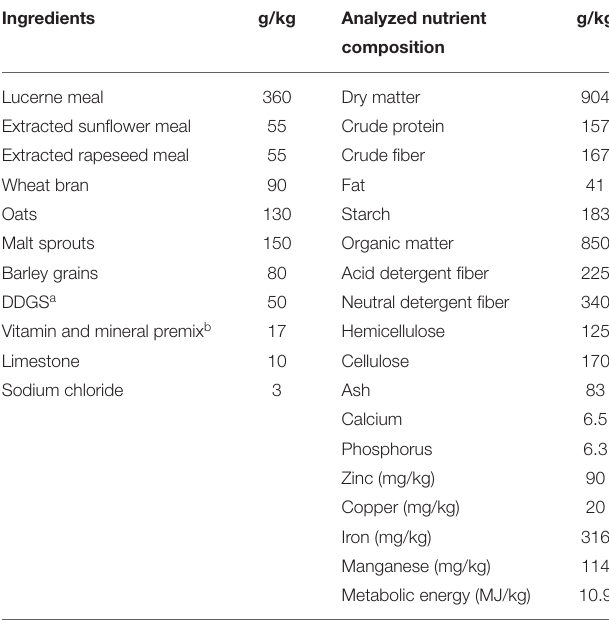
TABLE 1 | Ingredients and chemical composition of the granulated basal